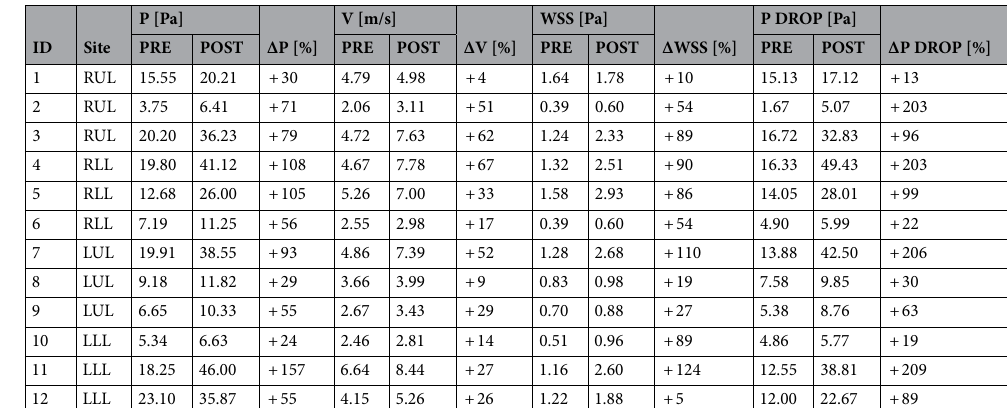
Table 3. Maximum values of wall pressure, wall shear stress, velocity and pressure drop in the pre and post- operative cases. The respective variations with respect to the pre-operative values are also